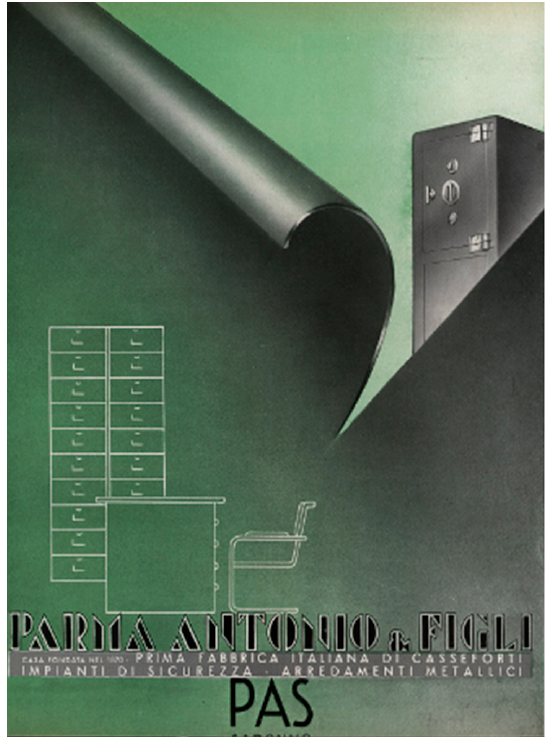
Figure 43. Advertising PAS (Parma Antonio & Figli). Image from Domus (1936).